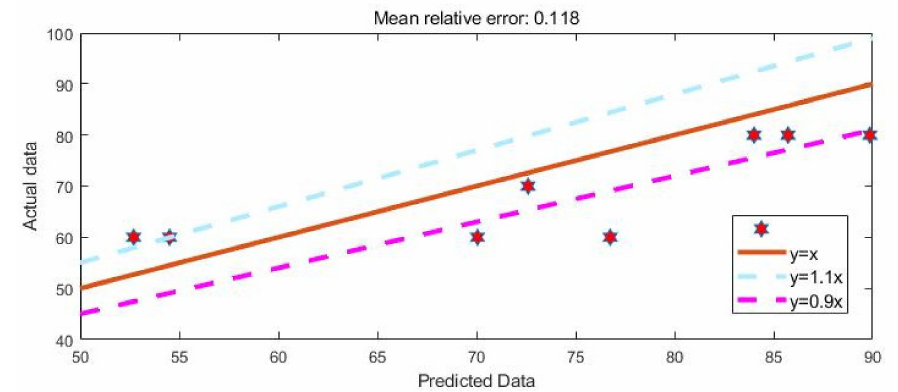
Figure 25. Error analysis of RBF neural network